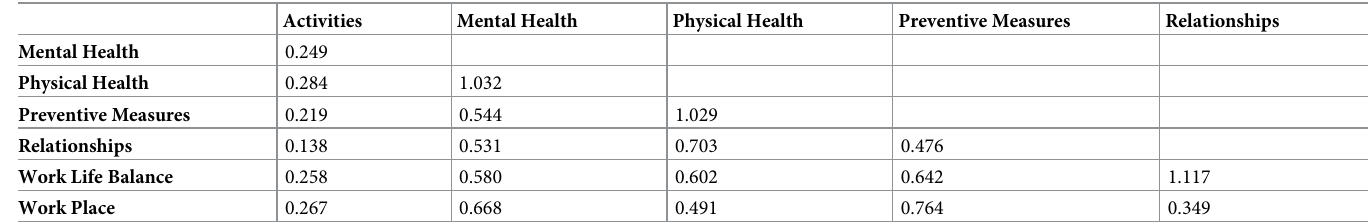
Table 7. HTMT ratios of constructs.